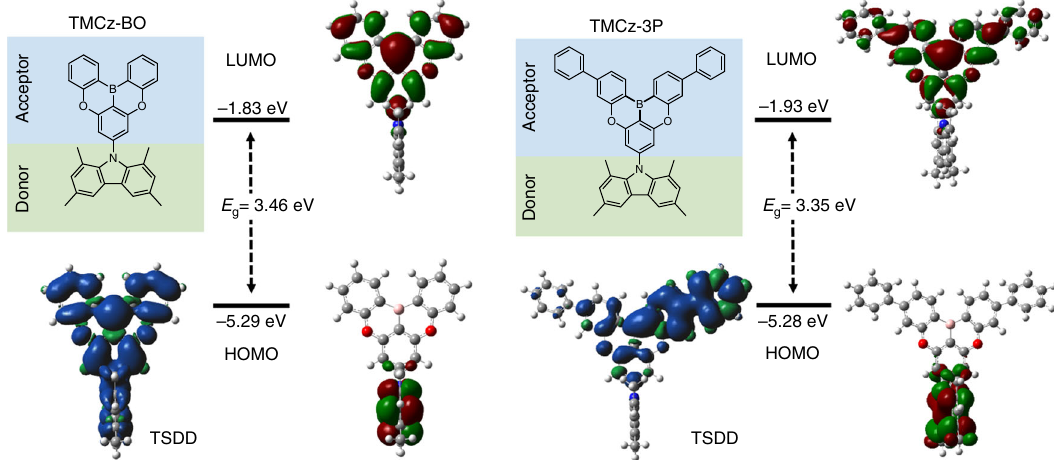
Fig. 1 Molecular structures and energy levels. HOMO and LUMO of TMCz-BO and TMCz-3P characterized by DFT calculations at the PBE0/6-31G(d) level of theory and TSDDs in T 1